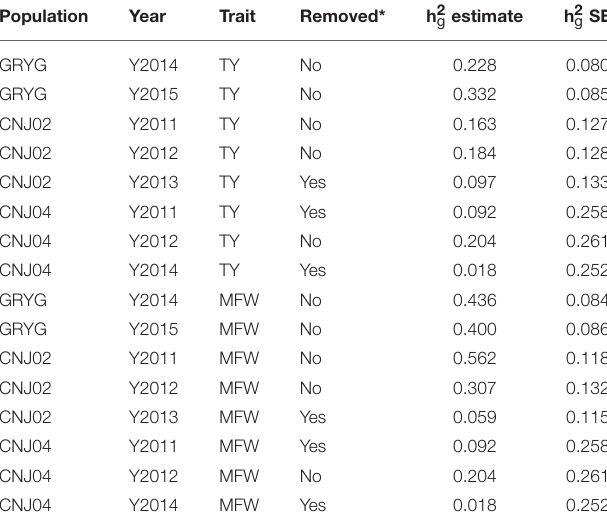
* Posterior analysis based on multivariate mixed models were not calculated when the genomic heritability for the univariate models was < 0.10.